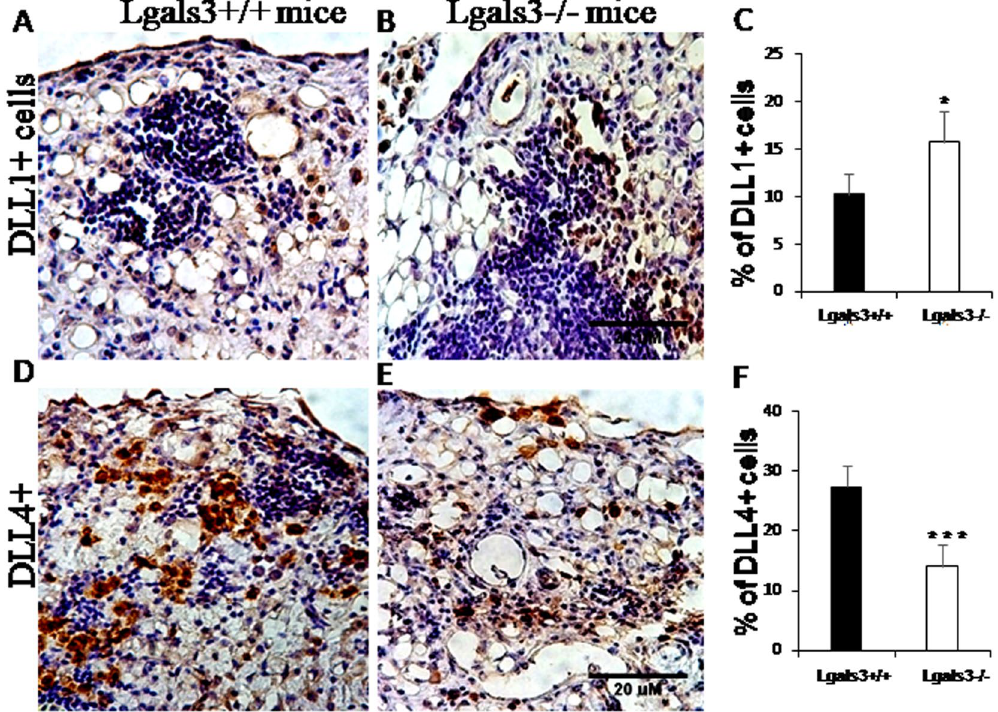
Figure 7. Immunohistochemistry to Notch ligands on pristane-induced mice. Delta-like-1 (DLL1) was markedly present in cells surrounding milky spots in Lgals3 + / + induced by pristane ( A ). In Lgals3 − / − , these cells were randomly dispersed through mesentery ( B ). Bars graphs indicate the percentage of DLL1 + cells ( C ). Delta-like-4 (DLL4) expressing cells were found in clusters dispersed by submesothelium region in Lgals3 + / + ( D ). In Lgals3 − / − , these cells were observed in all compartments of the mesentery ( E ). The quantity of cells was plotted in graph bars ( F ). Black bars represent Lgals3 + / + mice whereas white bars represent Lgals3 − / − mice. Data are representative of three independent experiments. Magnification: A-D (200 × ). ( * ) indicates p < 0.05. ( *** ) indicates p < 0.001.